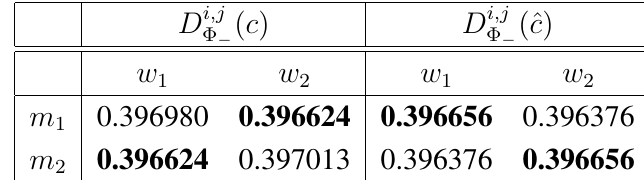
Table 1. Divorce Probabilities in Example 1 (Probabilities for Matched Pairs in